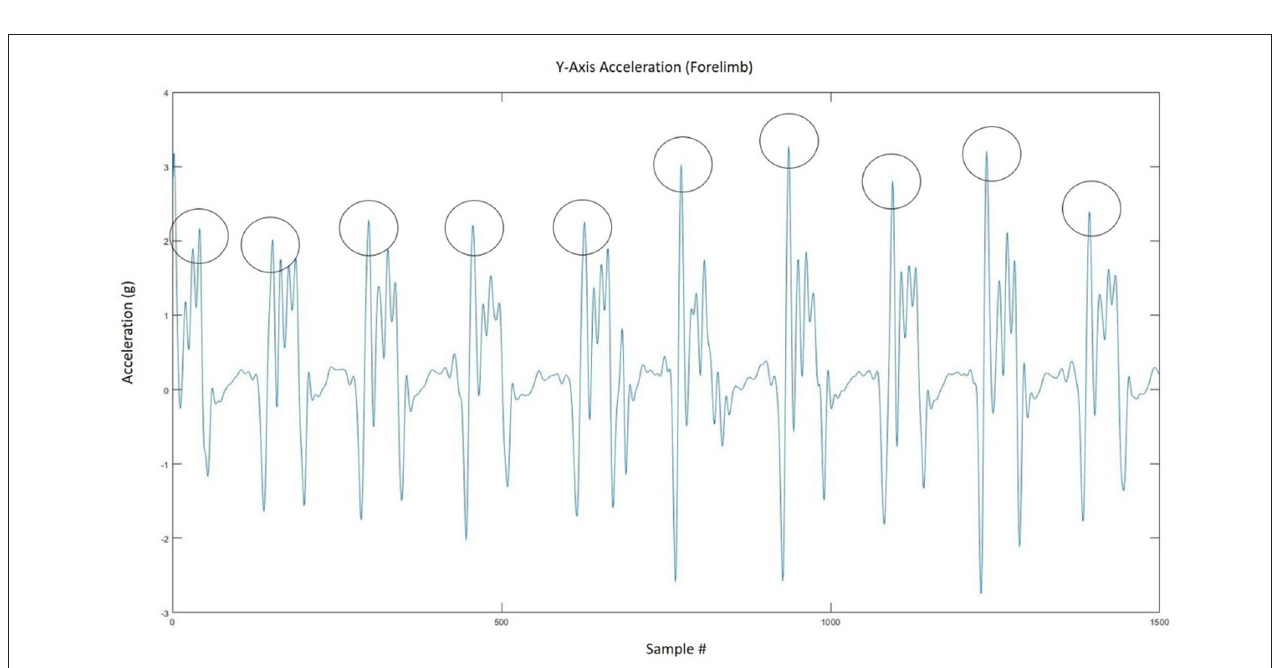
FIGURE 3 | Representative figure showing how the peak detection algorithm extracted the number of steps from the accelerometer signal.